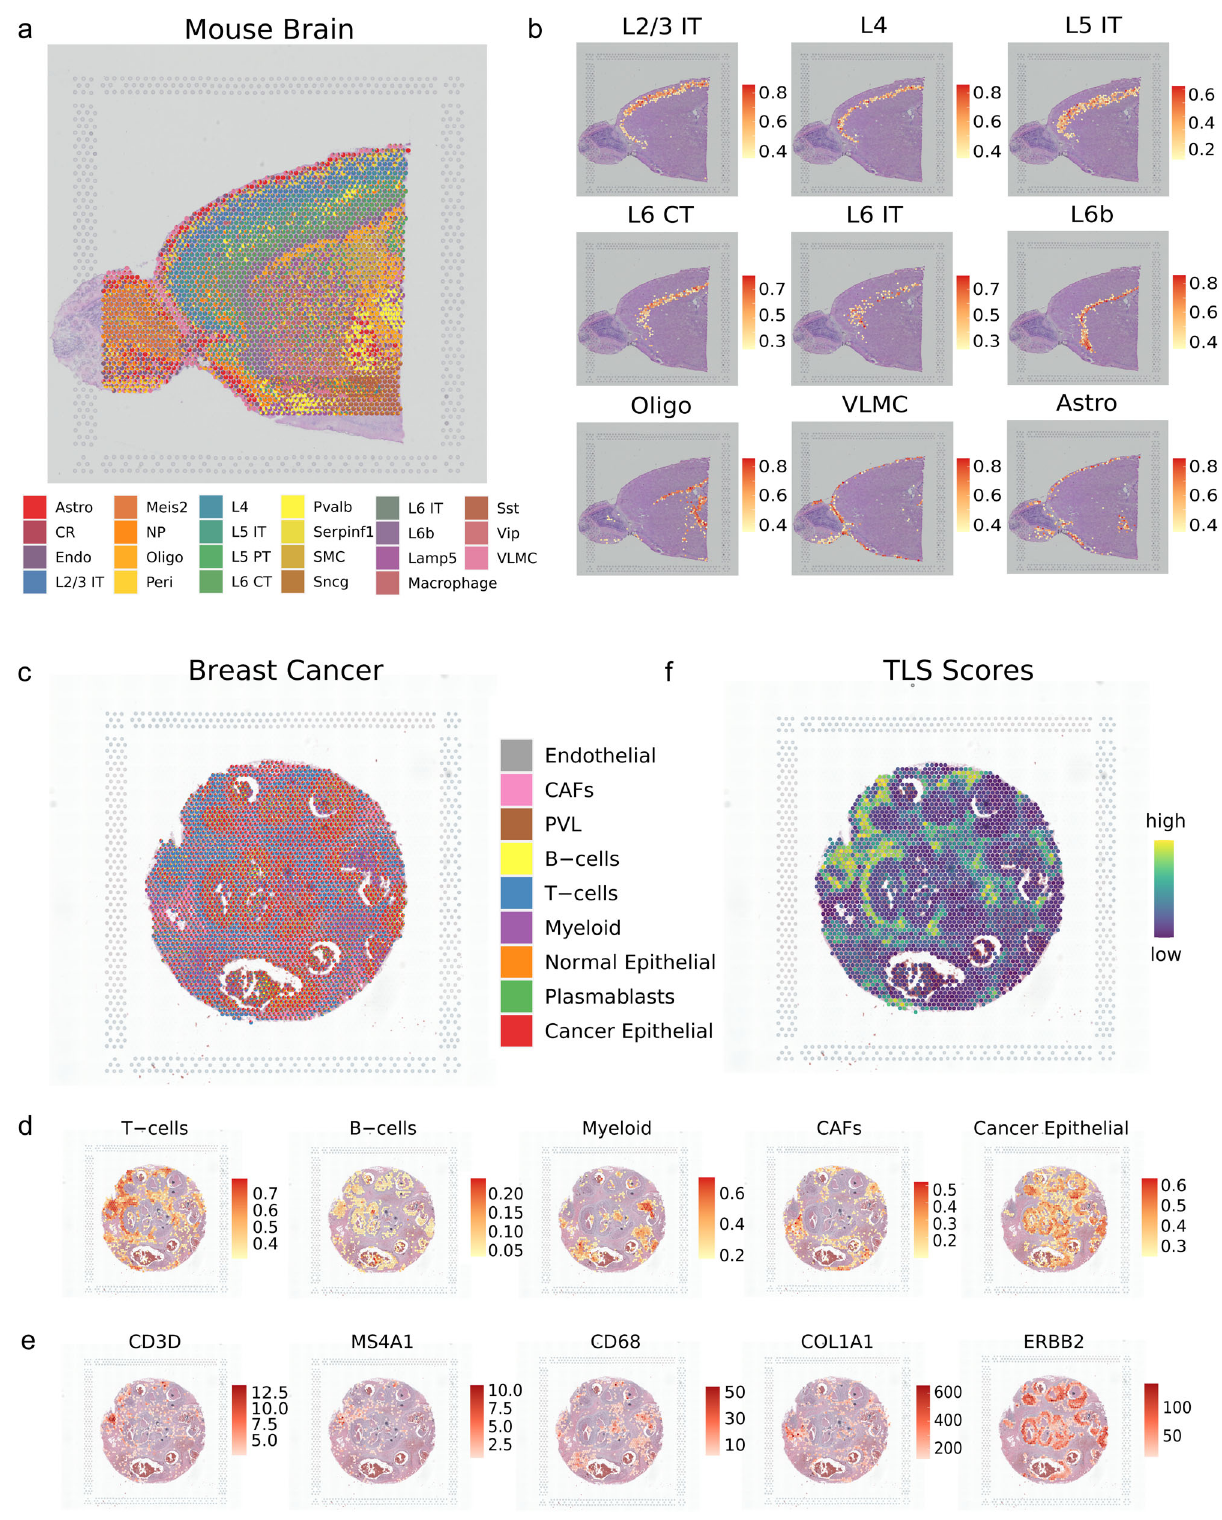
Fig. 6 | uniPort identi fi es iconic structures in spatial transcriptomic data (10× Visium). a Results of mapping spatial data to single-cell data using the optimal transport plan. Spatial scatter pie plot displays the well-structured cluster com- position in adult mouse brain anterior slice. b Lists of canonical cerebral cortical neuron types with scaled proportion. c Spatial deconvolution result of the